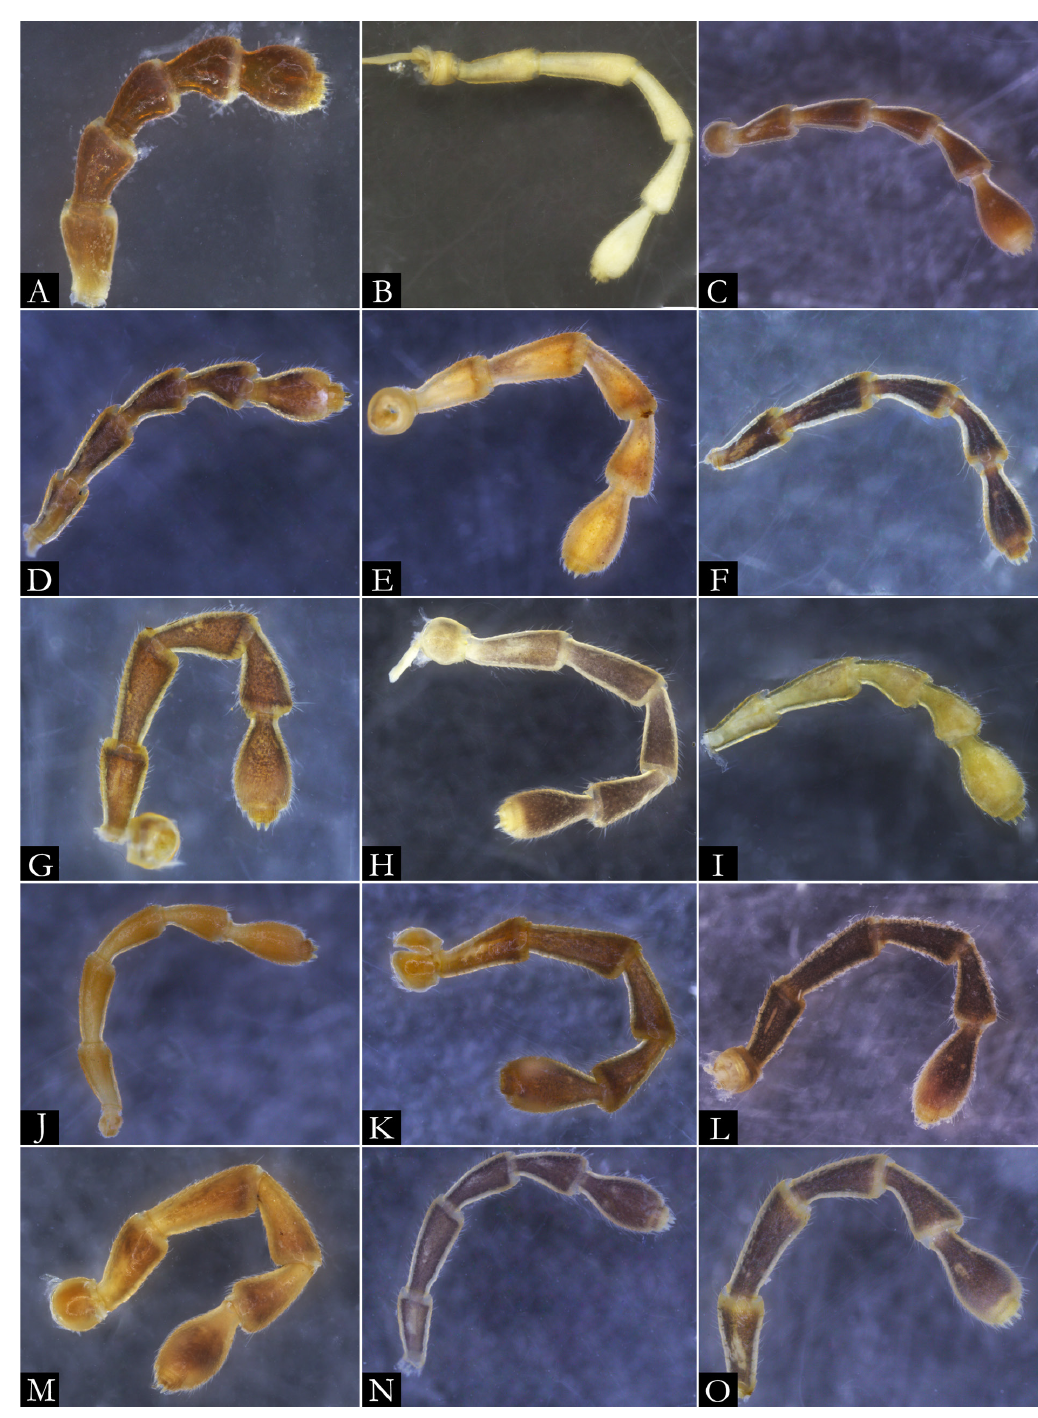
Fig. 163. Stereoscopic images of antennae of species of Pseudonannolene Silvestri, 1895. A . P.